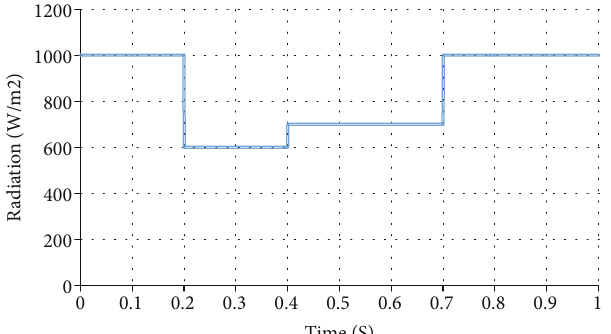
Figure 33: The radiation of partial shading condition.